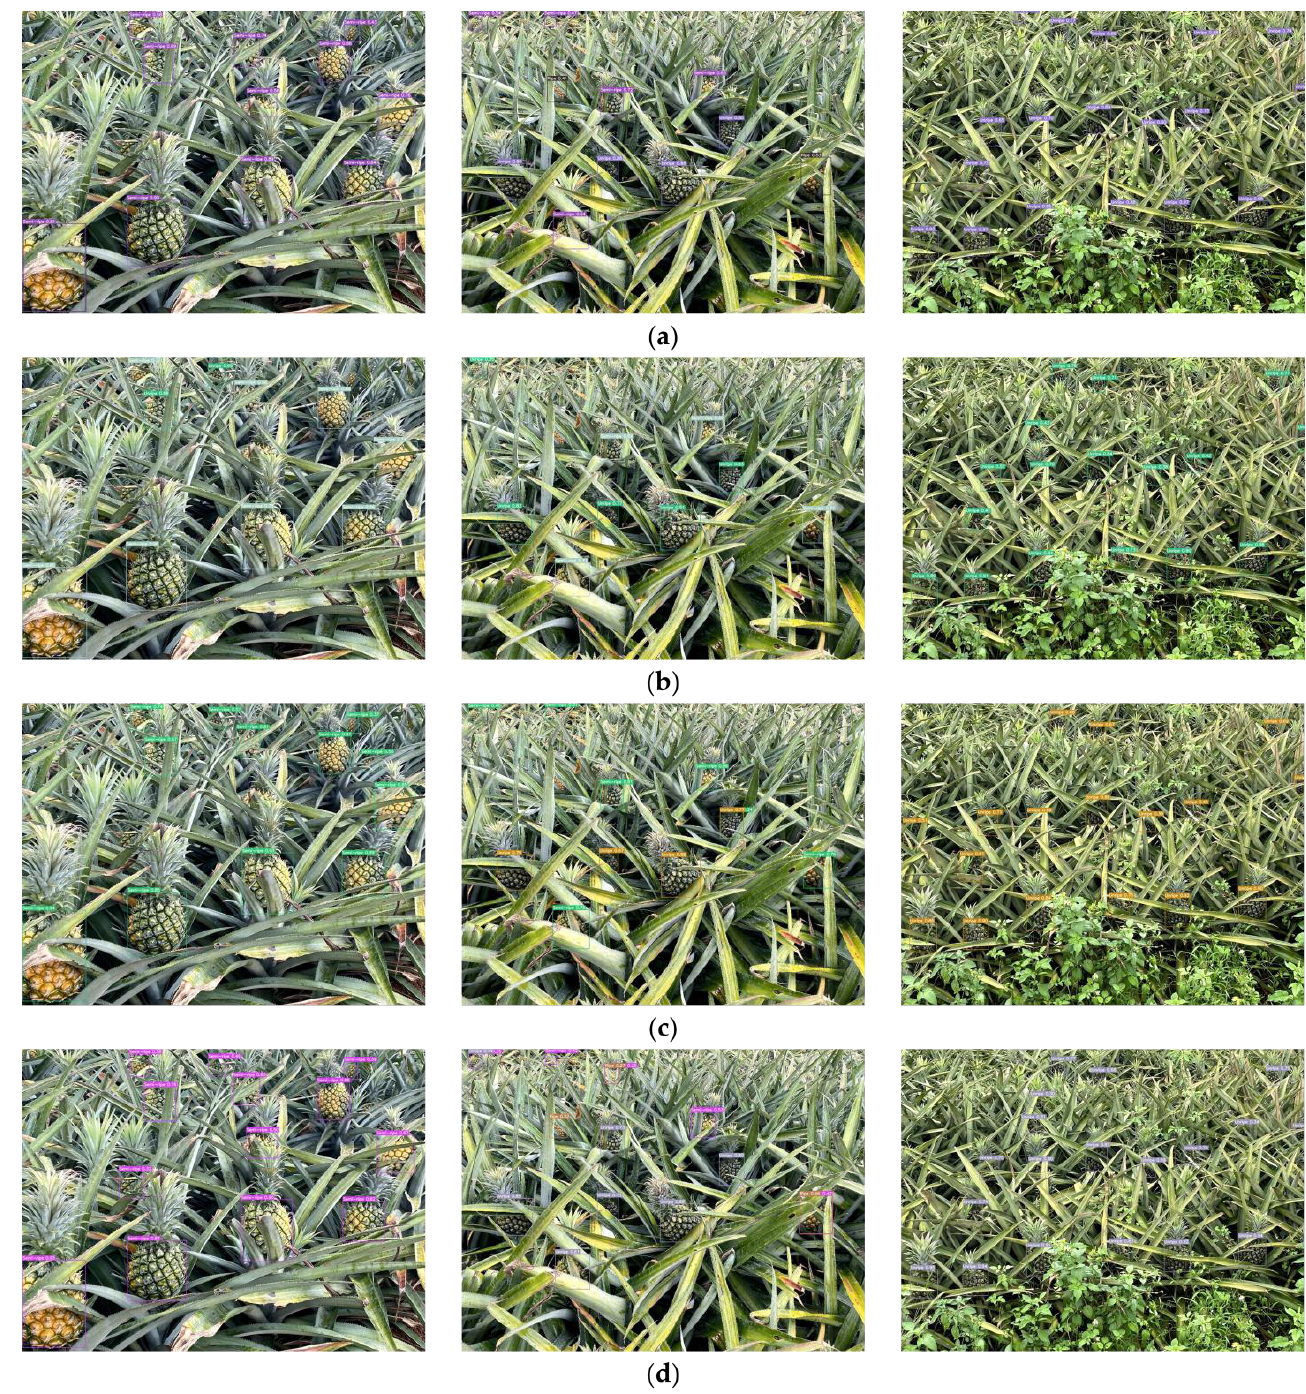
Figure 11. Comparison of the detection results of the four models on pineapples. ( a ) YOLOv4- Tiny; ( b ) YOLOv5s; ( c ) YOLOv7; ( d ) Ours. ( b ) YOLOv5s; ( c ) YOLOv7; ( d )